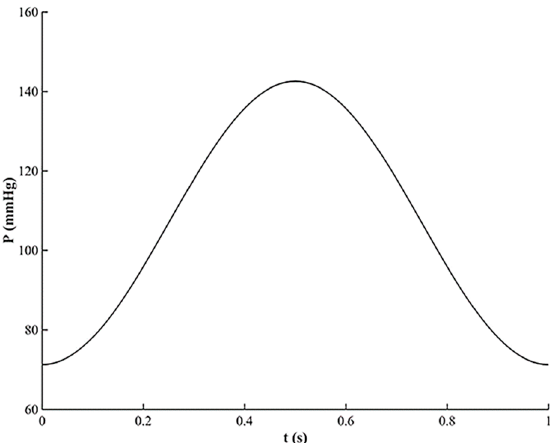
Figure 3. The time variation of the pressure used as the inlet boundary condition for the TEVG.